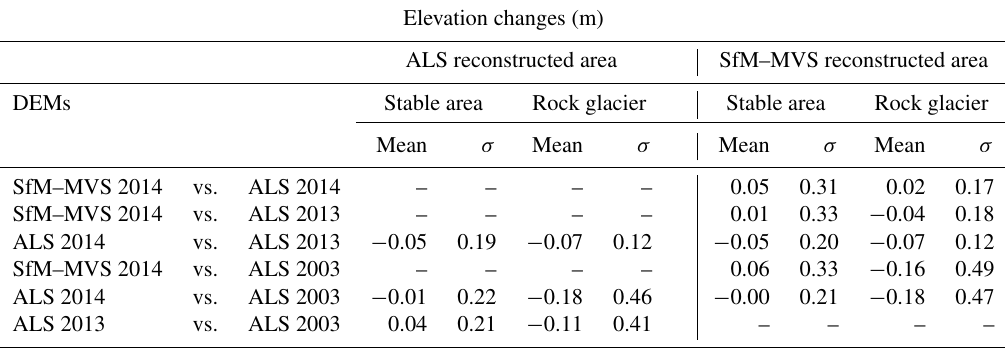
Table 5. Statistics of elevation changes in the rock glacier and in bare-ground stable area outside the rock glacier from September 2014 to September 2013 and from September 2003 in the ALS reconstructed area and in the common ALS and SfM–MVS coverage